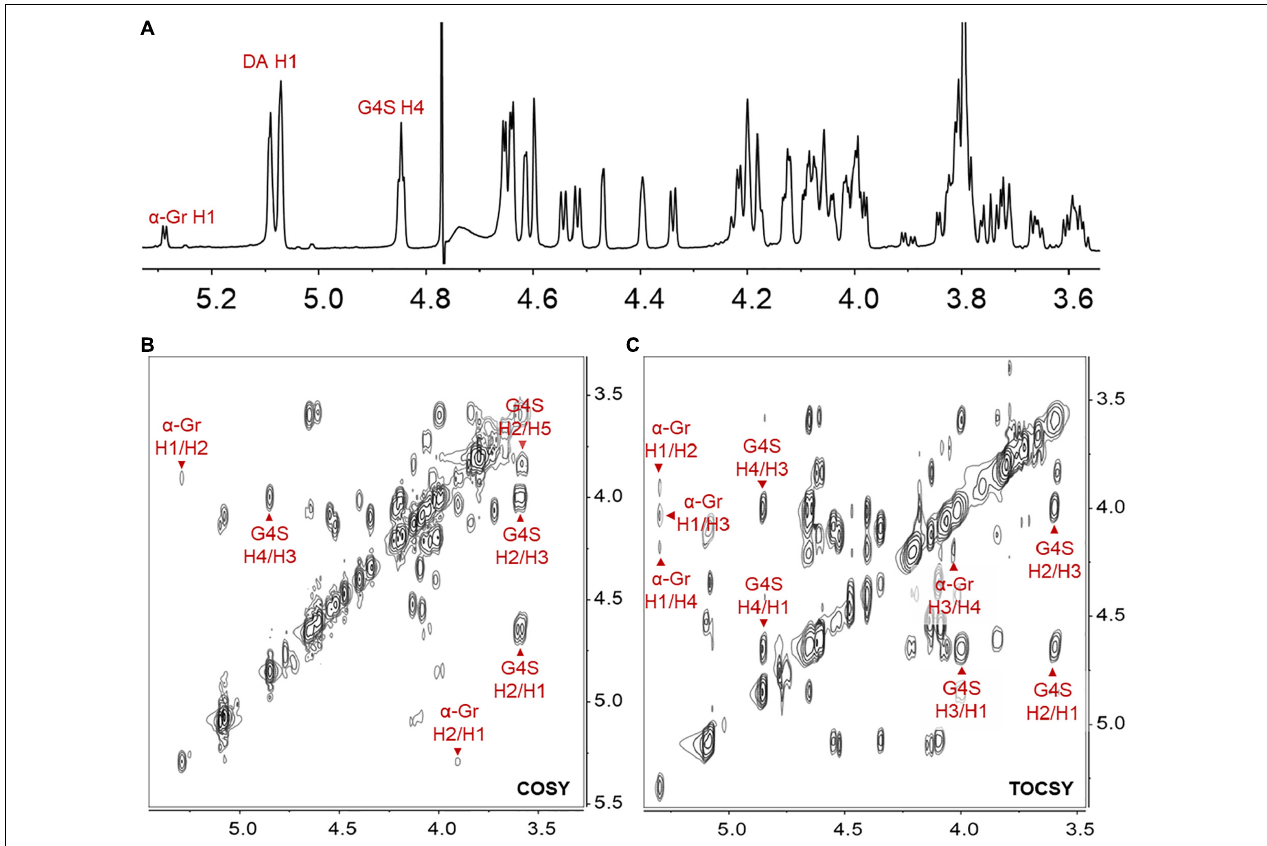
FIGURE 7 | The 1 H NMR (A) , COSY (B) , and TOCSY (C) spectra of the hexasaccharide (DA-G4S) 2 (DA-G) 1 purified from the final product. The axes are 1 H chemical shifts (ppm). The α -Gr indicated the α -G residue located at the reducing end; H1/H2 indicated the cross-peak between H-1 and H-2, etc. The 1 H NMR, COSY, and